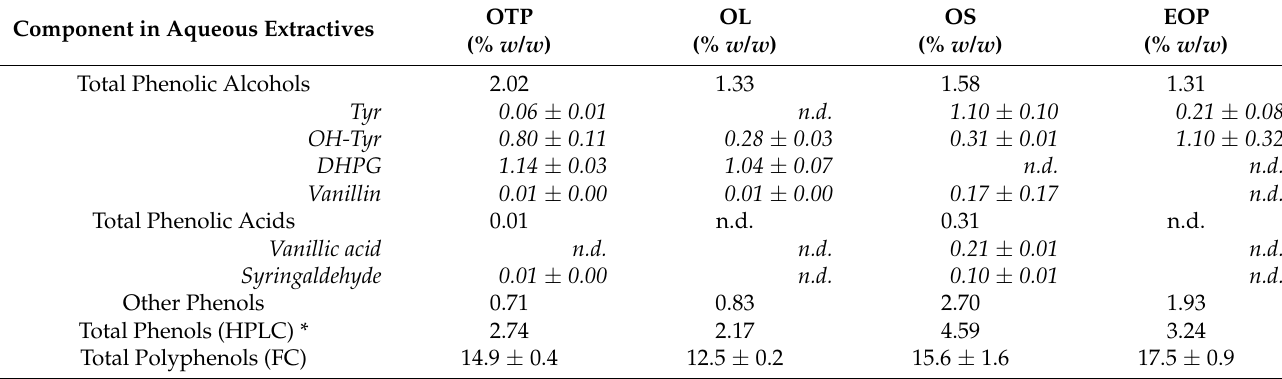
Table 5. Presence of water-extracted phenolic compounds for each olive by-product (% w/w of aqueous extractives). Component in Aqueous